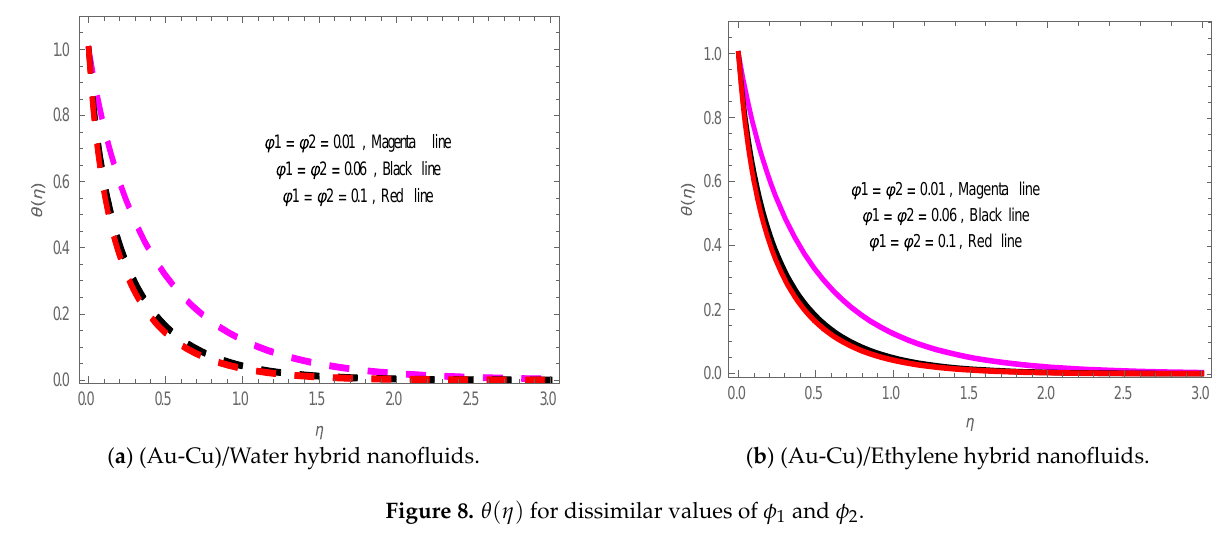
Figure 7. 𝜃(𝜂) for (Au-Cu)/Water and (Au-Cu)/Ethylene hybrid nanofluids.